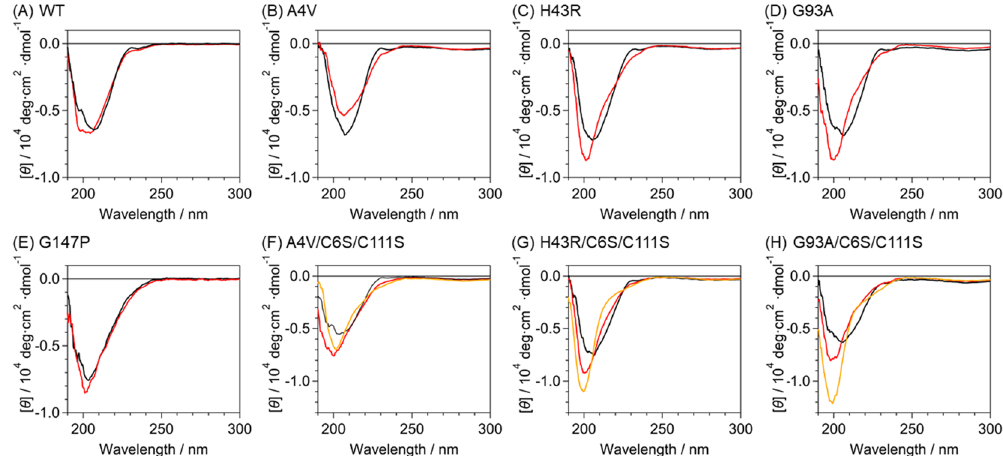
Figure 2. CD spectra of ( A ) apo-WT, ( B ) apo-A4V, ( C ) apo-H43R, ( D ) apo-G93A, ( E ) apo-G147P, ( F ) apo- A4V/C6S/C111S, ( G ) apo-H43R/C6S/C111S, and ( H ) apo-G93A/C6S/C111S in 50 mM phosphate buffer at pH 7.5 before and after the incubation (black and red lines, respectively). Details of the incubation conditions are given in Materials and methods and in the text. Panels F–H also show the CD spectra of the mutants after the incubation with 10 mM DTT (orange lines). DTT was removed using a desalting column before the CD measurement.